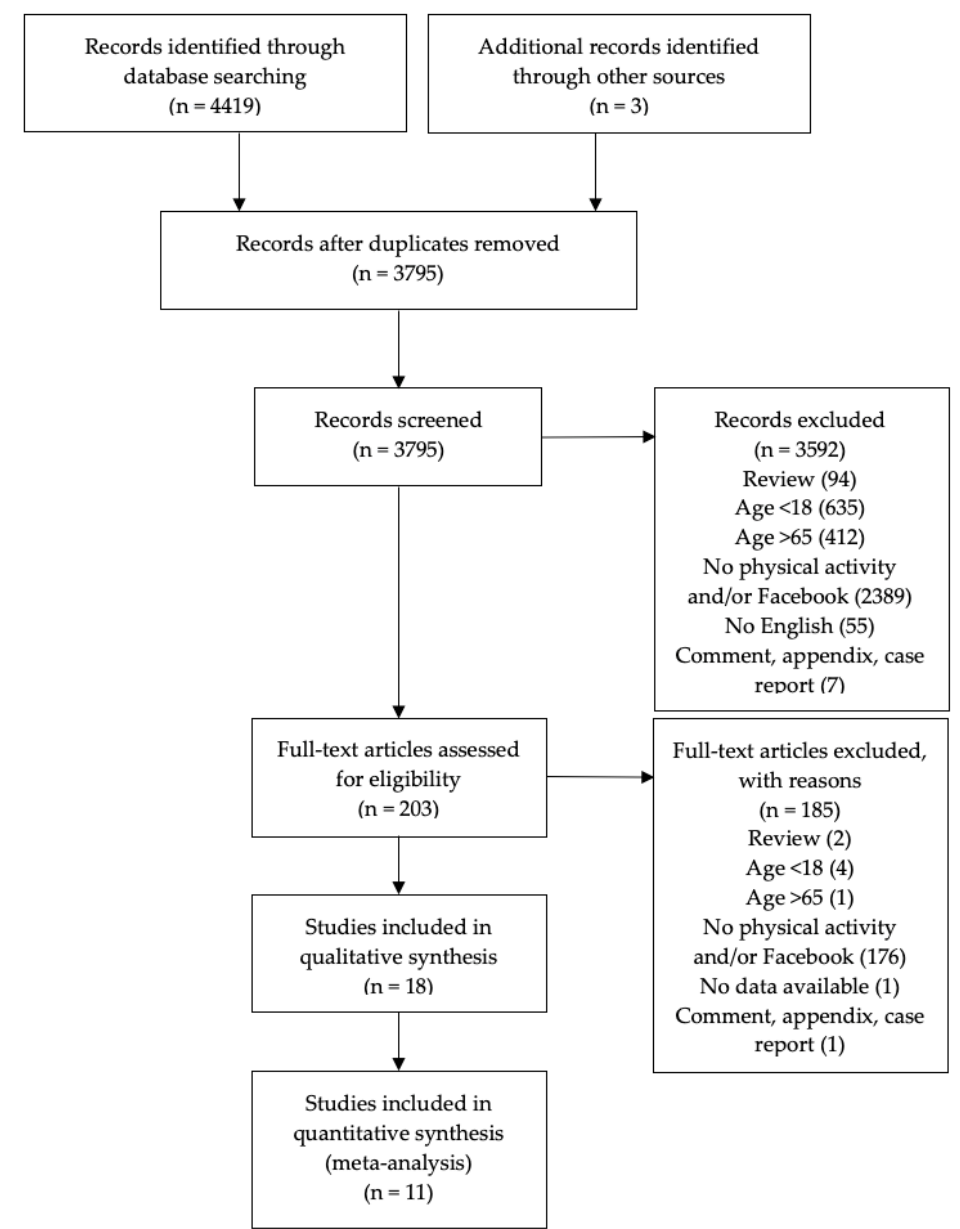
Figure 1. Flow chart of the literature research.